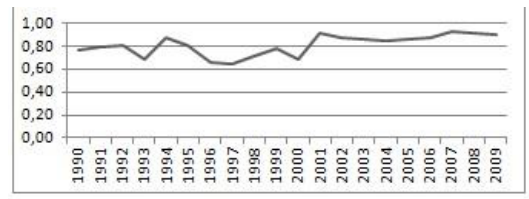
Figure 4. GL Index For EU